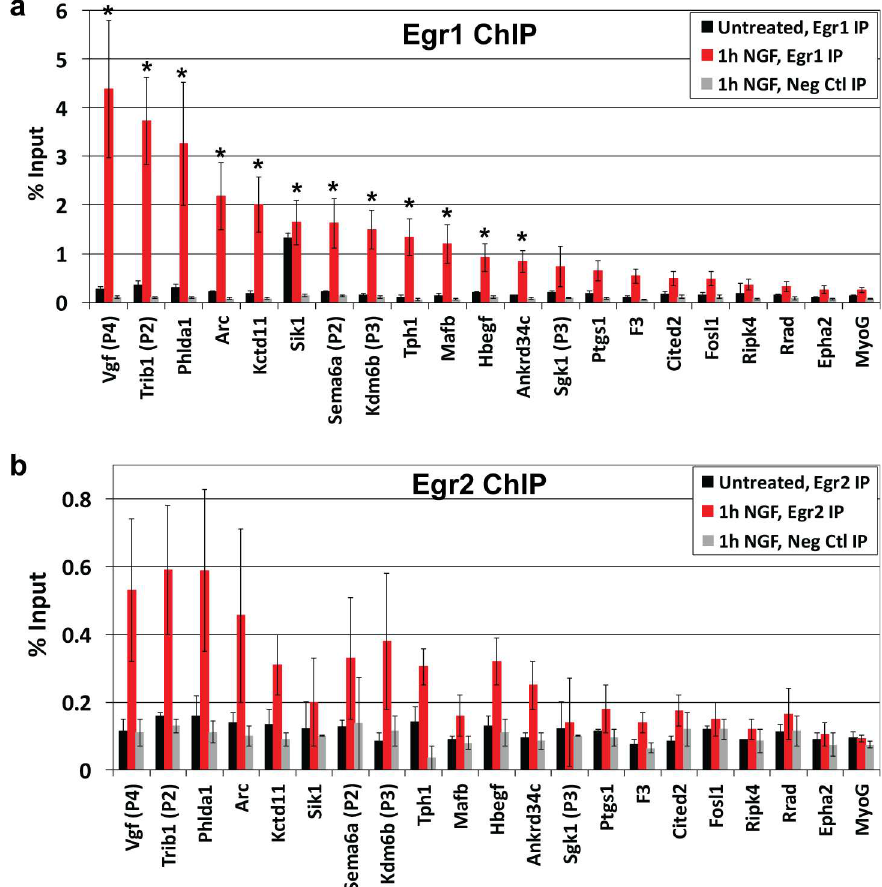
Fig 3. ChIP analysis to evaluate binding of Egr1 and Egr2 upstream of genes with predicted Egr binding sites. PC12 cultures were treated with or without 50 ng/ml NGF for 1 h and subjectedto ChIP assay using antibodiesagainstEgr1, Egr2, or an IgG control. Real-timePCR was then conductedon the immunoprecipitatedDNA using primers within 250 bp of each predicted Egr bindingsite (see Fig 1 and S2 Table for primer locations and sequences). For genes with multipledispersedEgr bindingsites, multiple primer sets (denotedP1, P2, etc.) were used; only data for the set that detected highest level of bindingare includedhere (see S1 Fig for data from the remainingprimer sets). Primers to amplify a region approximately 100 bp upstream of the Myog gene were used as a negativecontrol for Egr1 binding. (a) Data from Egr1 ChIP are plotted as % input and are averagesfrom three to four independent experiments ± S.E. * , One-tailed Student’s t tests were conducted comparingthe % input value for Myog after Egr1 IP to the % input values for each predictedEgr target after Egr1 IP, which yielded p values (cid:20) 0.05 for 12 predicted Egr targets. (b) Data from Egr2 ChIP are plotted as % input and are averagesfrom two independentexperiments ±